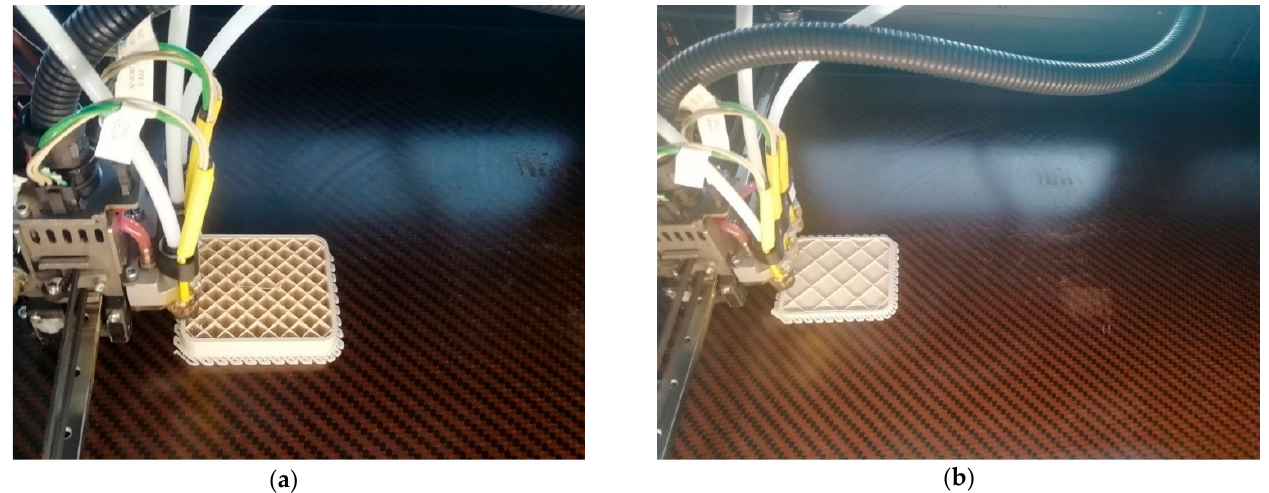
Figure 1. ( a ) Phenylene polysulfide thermoplastic (PPS) infill 10% rectilinear printing; ( b ) PPS infill 5% rectilinear printing.